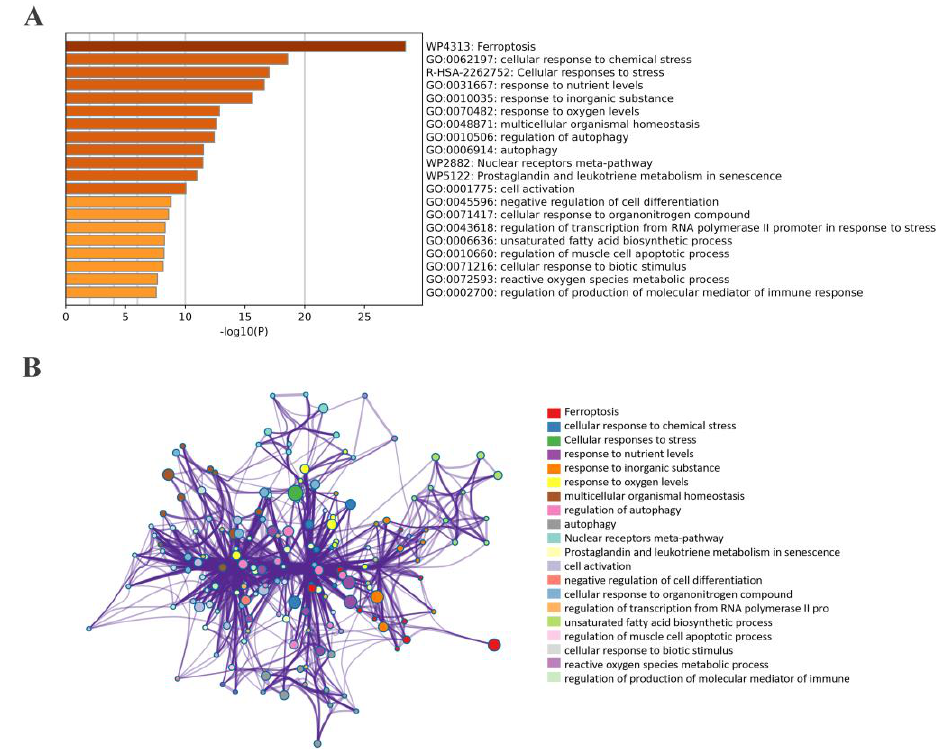
Figure 5. The bar graph and network of enrichment terms across 50 overlapped RRMS−related mod- ule genes in RRMS. ( A ) Bar graph of 20 enriched biological pathways, colored by p −values. ( B ) Net- work of enriched terms for specified genes analyzed by Metascape, colored by cluster